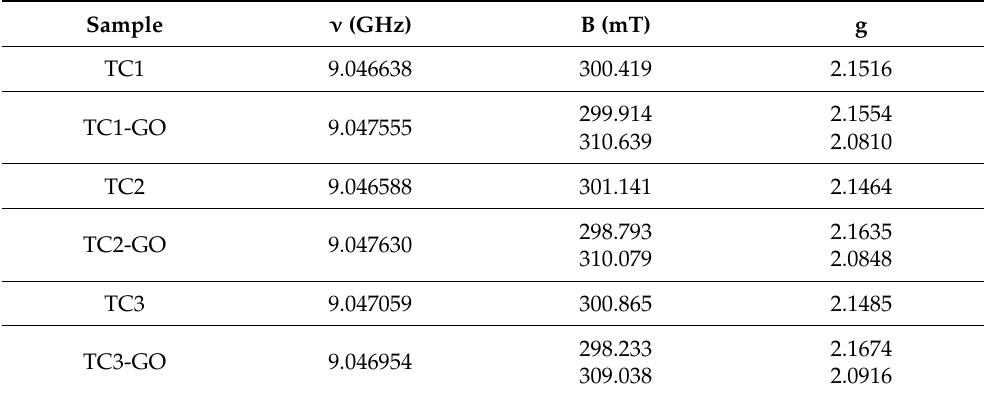
Figure 1. PL spectra of prepared nanocomposites compared to those of TiO 2 nanoparticles. Table 1. The g factors of the solid samples